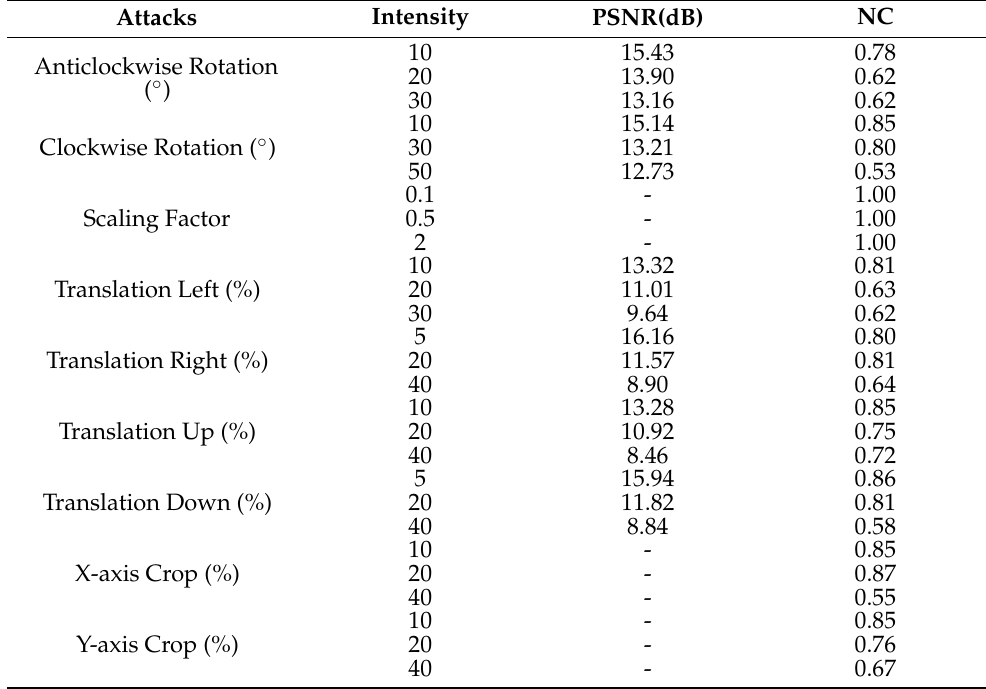
Table 4. Experimental data under geometric attack.